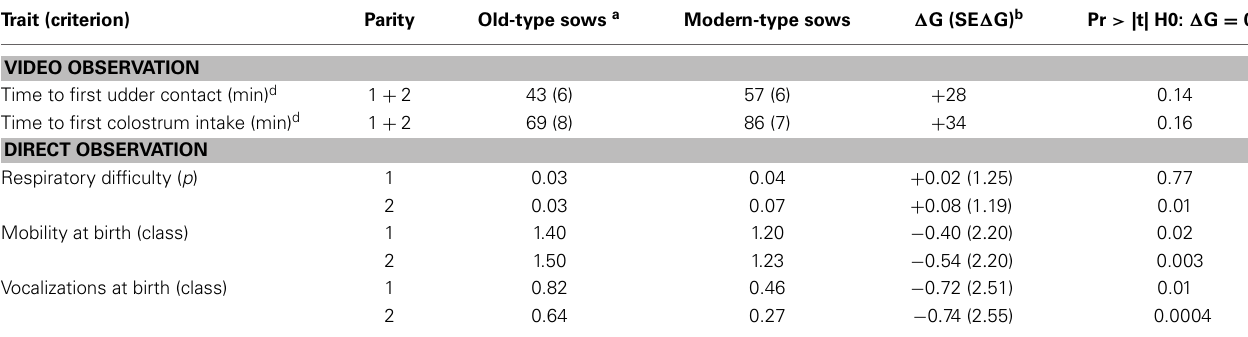
Table 6 | Genetic trends for newborn piglet behavior. Trait (criterion)